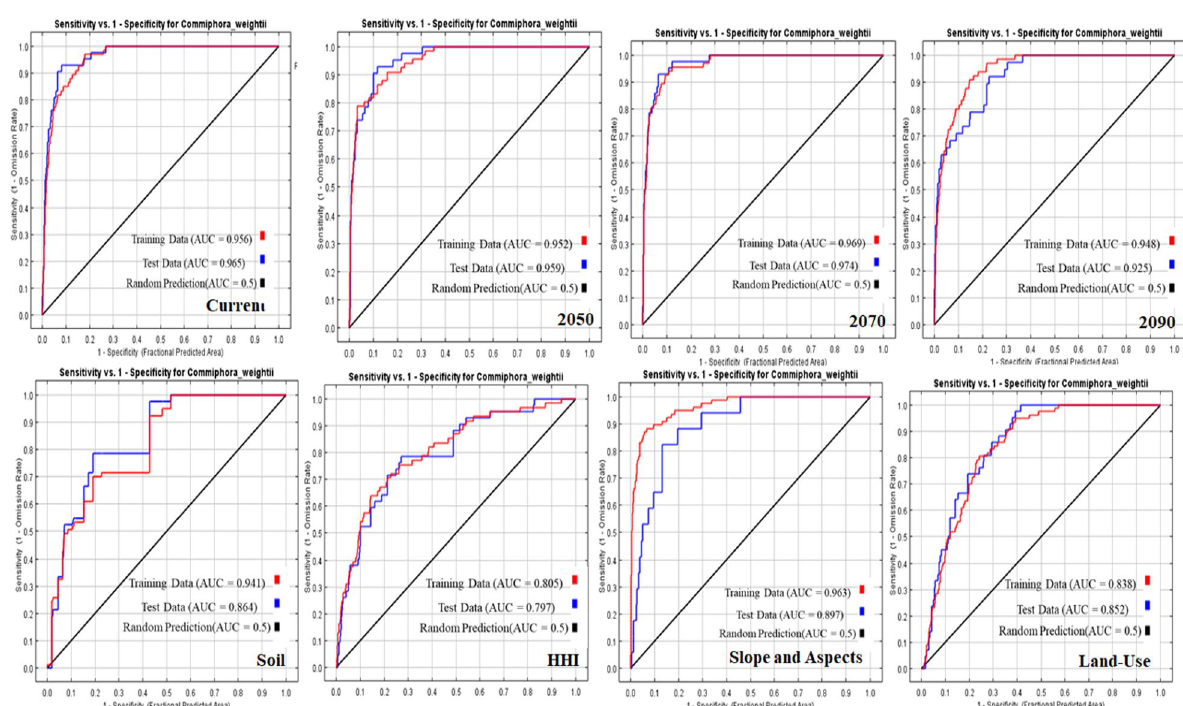
Fig. 2 Area under receiver operating characteristics curve (AUC) graphs for model performance (both training and test data set) belongs to four bioclimatic (current, 2050; 2070 and 2090) and four non-bioclimatic variables (soil, habitat heterogeneity indices, slope and aspects and land use)